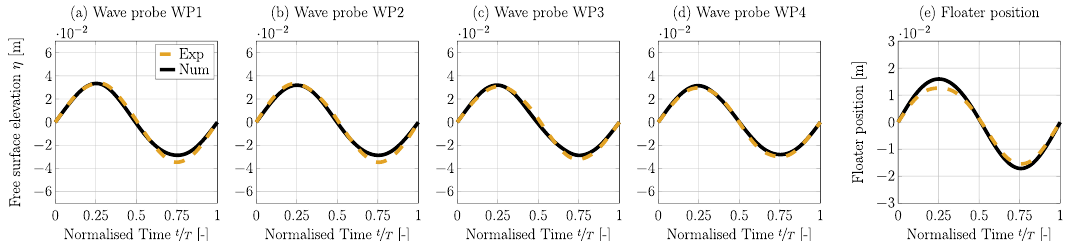
Figure 22. Phase-averaged free surface elevation, measured at wave probes WP1–WP4 ( a – d ), and floater position ( e ) for wave RW2.